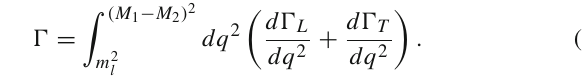
recoil region. On the other hand, for large recoil, the diquark transition currents are derived from the matching between QCD and DiET at tree level. Furthermore, we simpilfied DiET as HDiET in the heavy diquark limit, from which we reduced the form factors of the doubly heavy baryon transi- tion to only one function η(w) . The reduced vector matrix element is the same as those derived by heavy quark-diquark symmetry in earlier works. In addition, we pointed out that η(w) is related with the universal soft function which is pro- portional to the Isgur-Wise function of heavy meson decays. Thus we obtained the q 2 -dependence of η( q 2 ) by assum- ing a monopole structure. Finally, the obtained form factors are used to predict the semi-leptonic decay widths of dou- bly heavy baryons, and the results are consistent with those derived by LFQM in the earlier